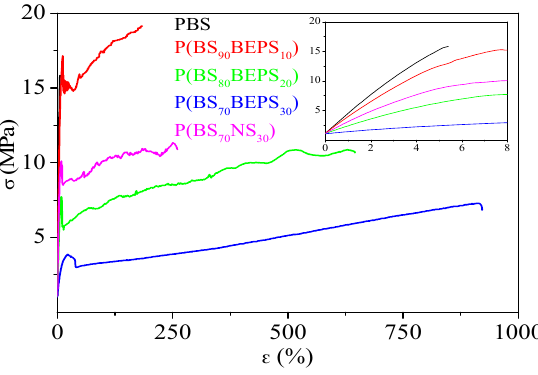
Figure 6. Stress–strain curves of PBS, P(BS m BEPS n ) and P(BS 70 NS 30 ) random copolymers; in the inset: magnification of the low σ vs. ε region.